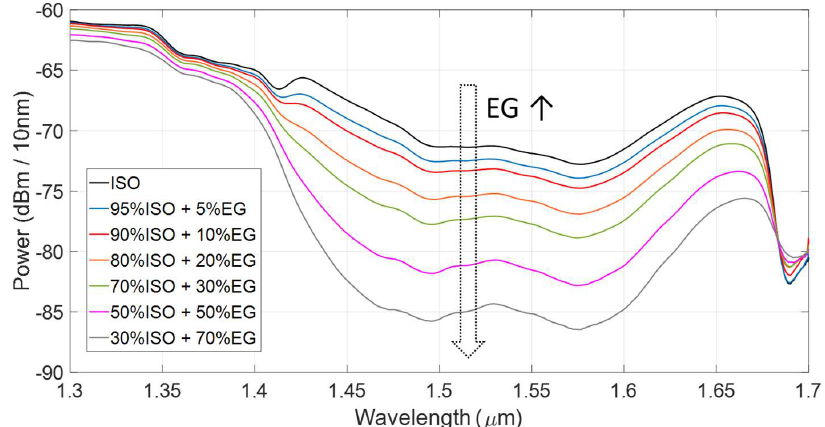
Figure 4. Experimental power spectra acquired when filling the capillary channel with isopropanol and isopropanol-ethylene glycol mixtures in various concentrations.